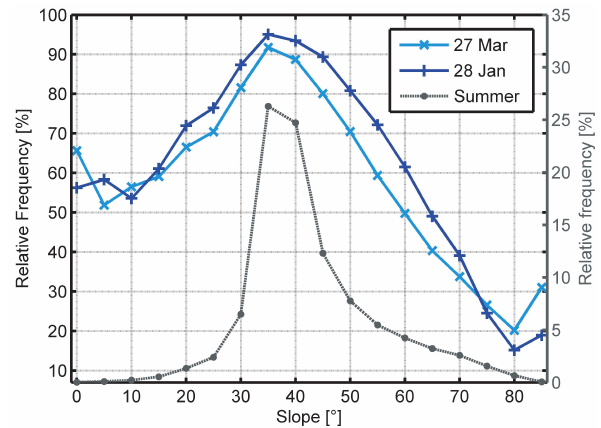
Fig. 9. The left axis shows the histogram with the relative frequen- cies of the snow covered cells per class (classes of cells with a step width of 5 ◦ slope) after a period with snowfall in combination with weak winds (28 January), respectively in combination with strong northwest winds (27 March). The right axis shows the histogram of the slope angle distribution in summer (based on DEM